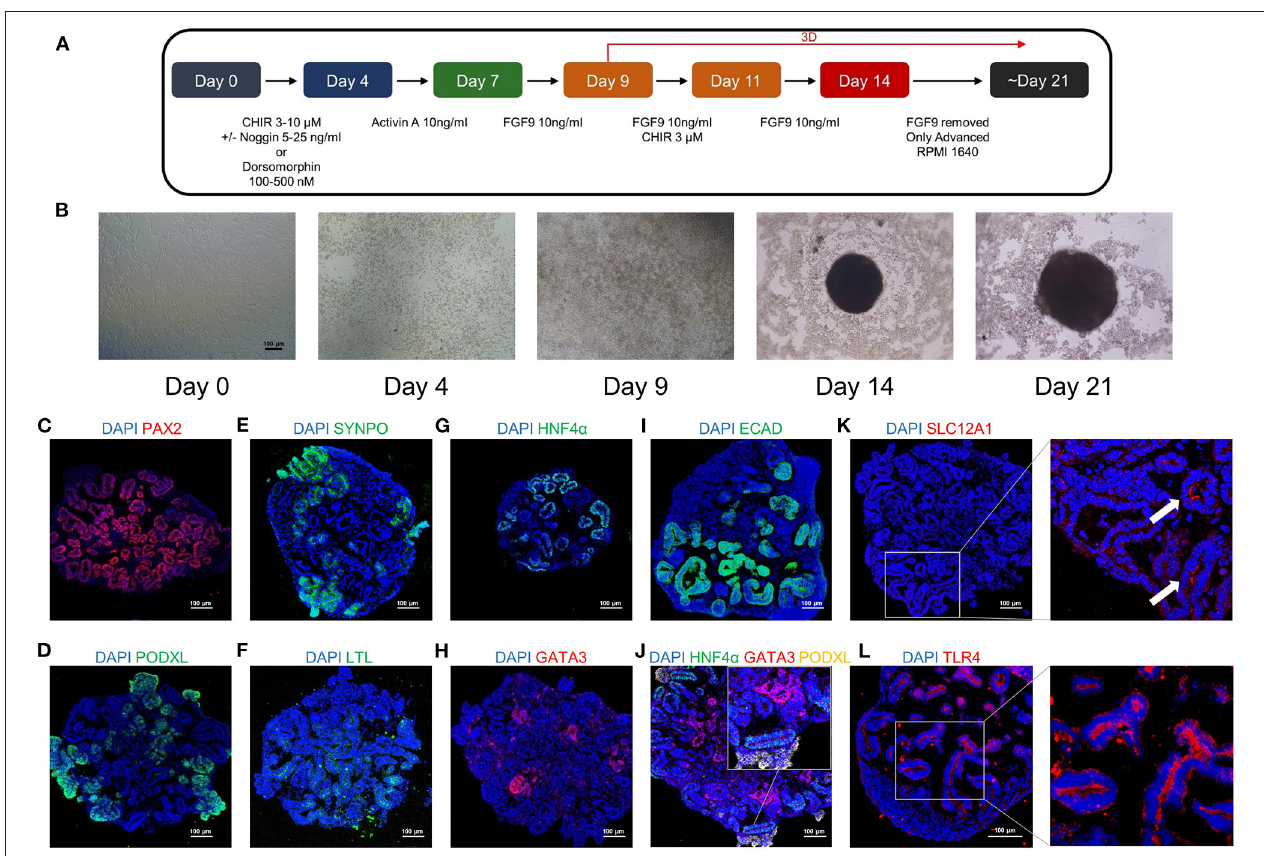
FIGURE 3 | The human pluripotent stem cells (hPSC)-derived kidney organoids contain different renal structures and expressed TLR4. (A) A schematic overview of the kidney organoids differentiation protocol. (B) Morphological changes of the kidney organoids differentiation under bright field observation. Kidney organoids in this study expressed the intermediate mesoderm marker (C) PAX2 (Red), the podocyte markers (D) podocalyxin (PODXL) (Green) and (E) synaptopodin (SYNPO) (Green), the proximal tubule markers (F) LTL (Green) and (G) HNF4 α (Green), the distal tubule as well as collecting duct markers (H) GATA3 (Red), and (I) E-cadherin (ECAD) (Green). (J) The association between HNF4 α (Green), GATA3 (Red) and PODXL (Yellow) in the kidney organoids. The expression pattern of the loop of Henle marker (K) SLC12A1 (Red) and the LPS receptor (L) TLR4 (Red) in the kidney organoids. DAPI is stained with blue fluorescence. Scar bar = 100 µ